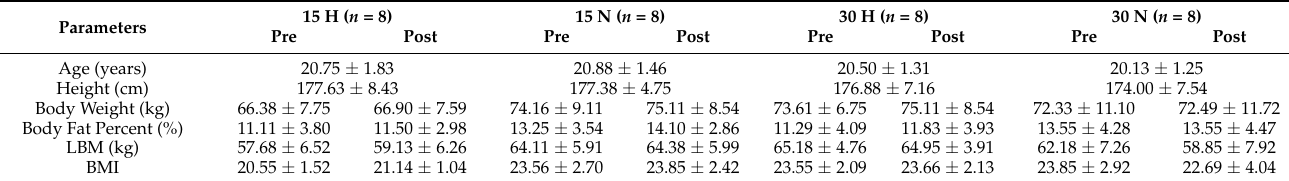
Table 1. Participant